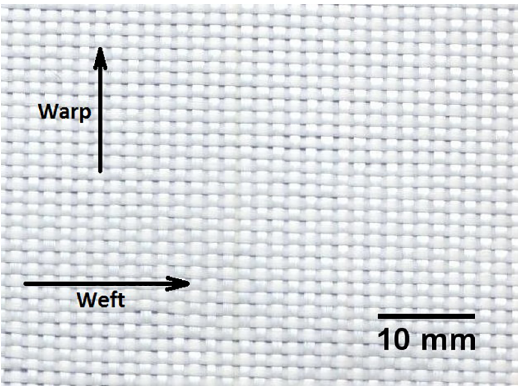
Figure 1. The woven E-glass fabric used in layer orientation 0º.